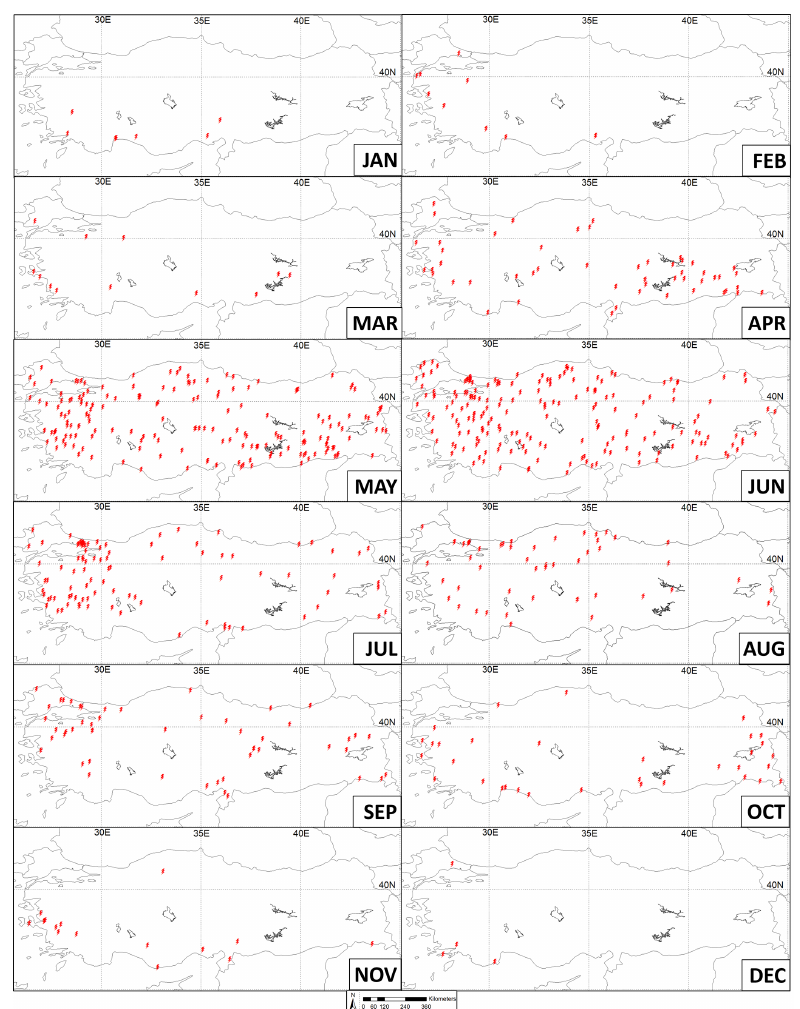
Figure 9. Locations of lightning incidents resulting in fatalities, injuries, or both, by month (January 1930 to June 2014). Multiple fatalities and injuries may occur at each red